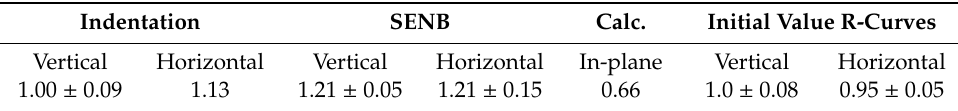
Table 1. Summary of the fracture toughness K Ic [MPa √ m].